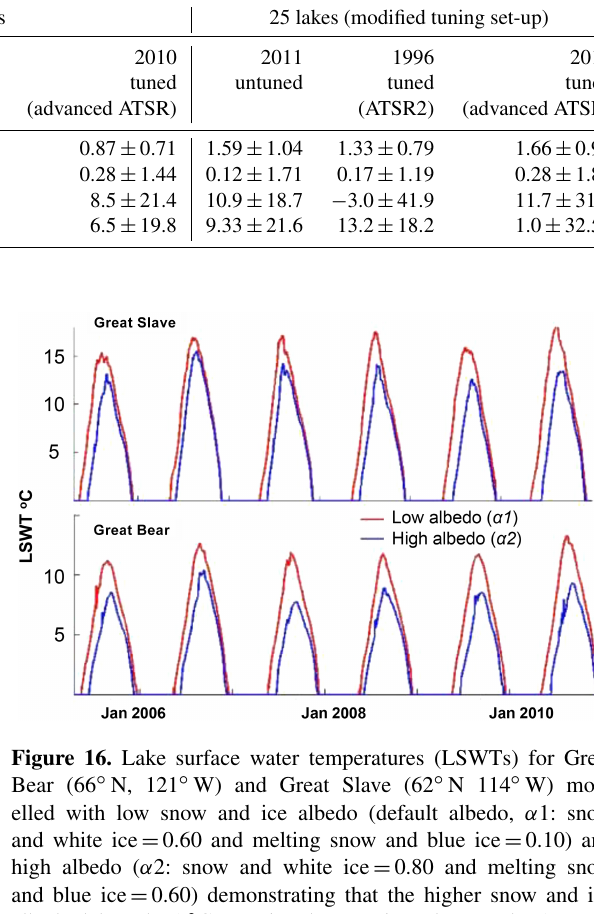
an earlier ice-off date, of ∼ 0.5 day yr − 1 . Foster and